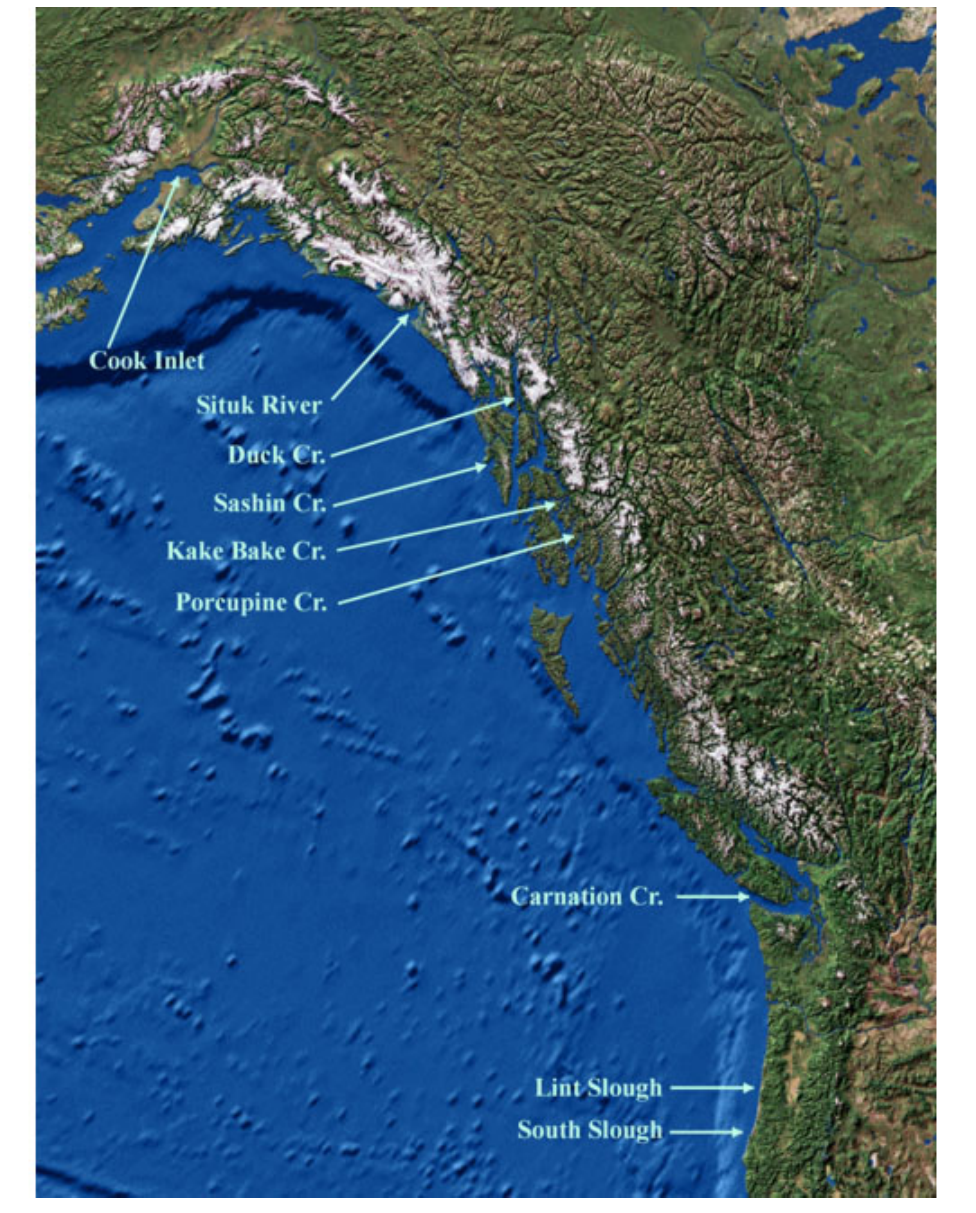
Fig. 2. Location of observed coho nomads rearing in stream-estuary ecotones or estuaries in the Pacific Northwest and